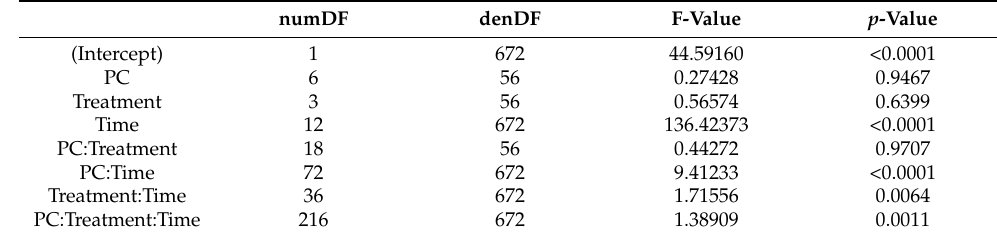
Table 2. Repeated-Measures ANOVA results of probiotic candidate (PC) growth rates incubated with four different treatments (control; 0.15; 1 and 10 ppb) over time (significant p -values < 0.05).